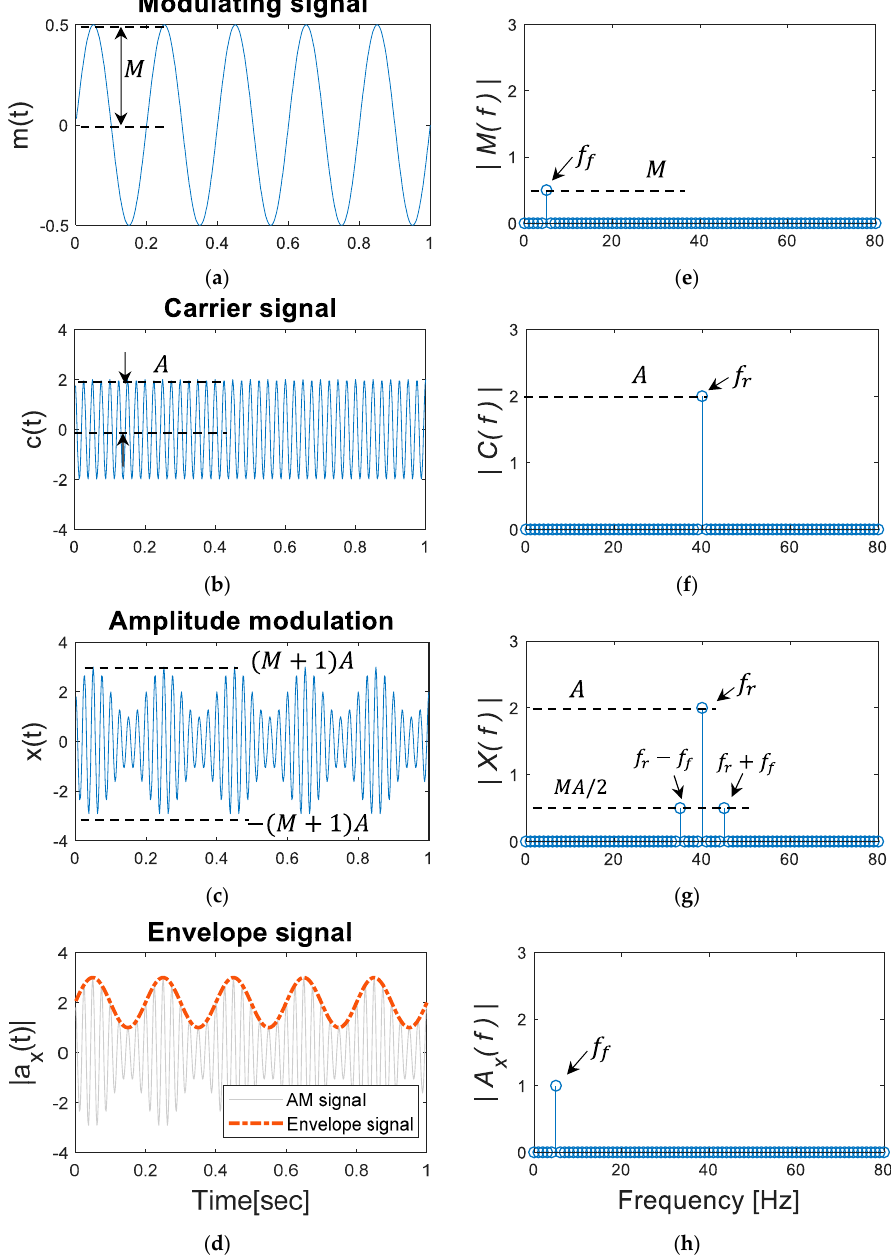
Figure 2. Amplitude modulation and envelope signal: ( a ) modulating signal, ( b ) carrier signal, ( c ) AM signal, ( d ) envelope signal, in the time domain; ( e ) modulating signal, ( f ) carrier signal, ( g ) AM signal, ( h ) envelope signal, in the frequency domain.